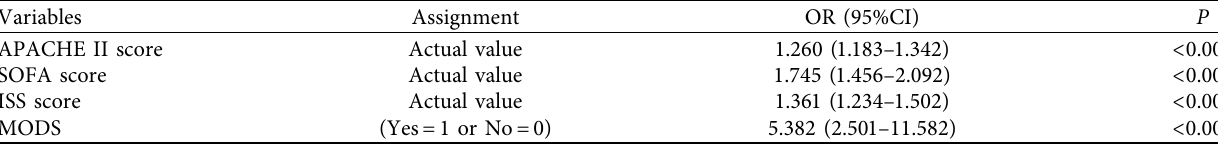
Table 3: Multivariate logistic regression analysis of independent risk factors for the occurrence of sepsis in multiple trauma patients. Variables